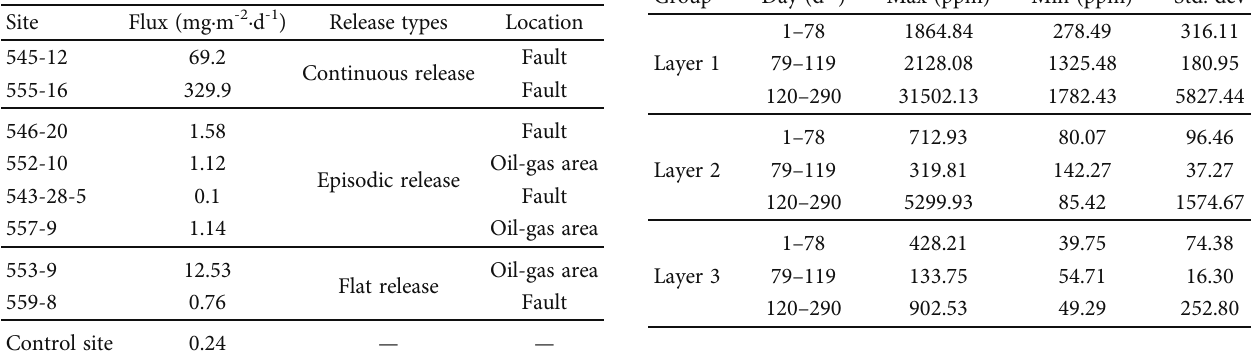
Table 2: Statistics of CH concentration (layers 1 – 4